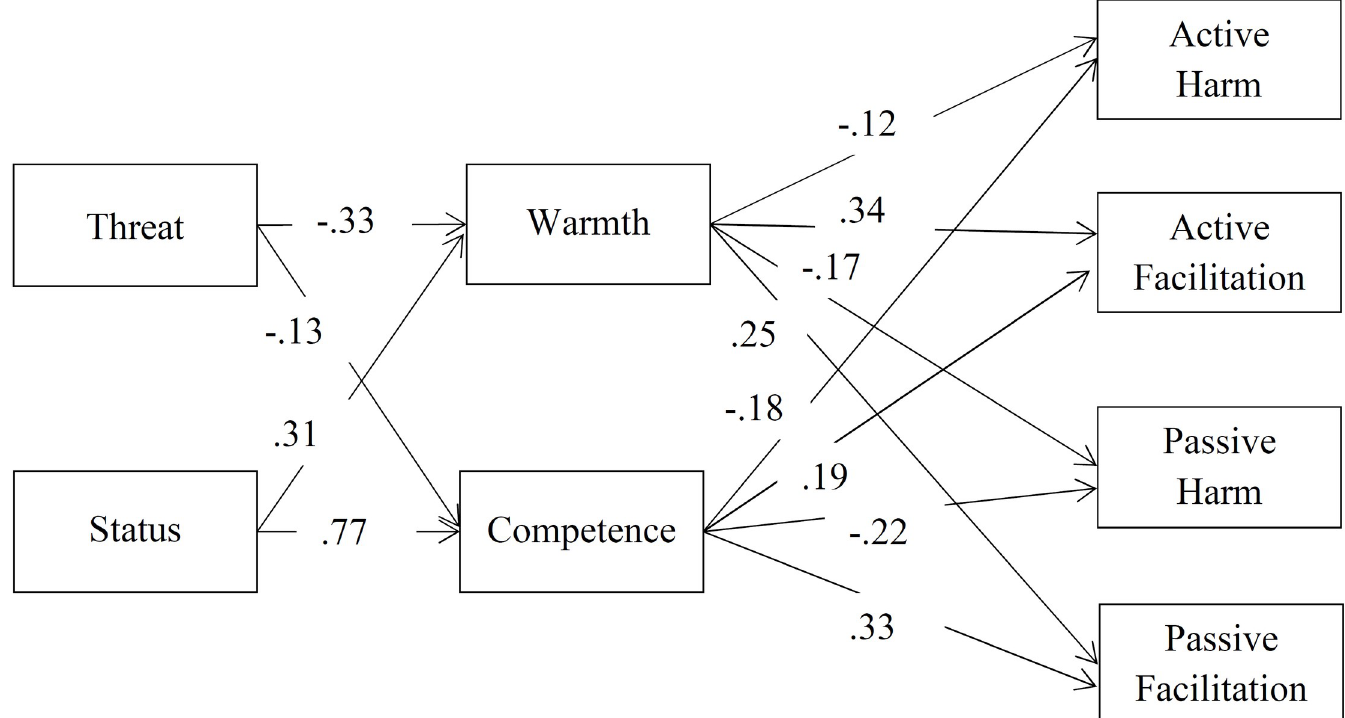
active harm and positively predicted active facilitation. Competence negatively predicted pas- sive harm and positively predicted passive facilitation. Furthermore, all additional exploratory paths were also significant. Threat negatively predicted competence, whereas status positively predicted warmth. In turn, warmth negatively predicted passive harm and positively predicted passive facilitation. Competence negatively predicted active harm and positively predicted active facilitation. Threat and Status were moderately and negatively correlated ( r = -.38, p < .001). Correlations of residuals were also significant (all p s < .001). The model explained the following amounts of variance in the dependent variables: warmth (29%), competence (71%),